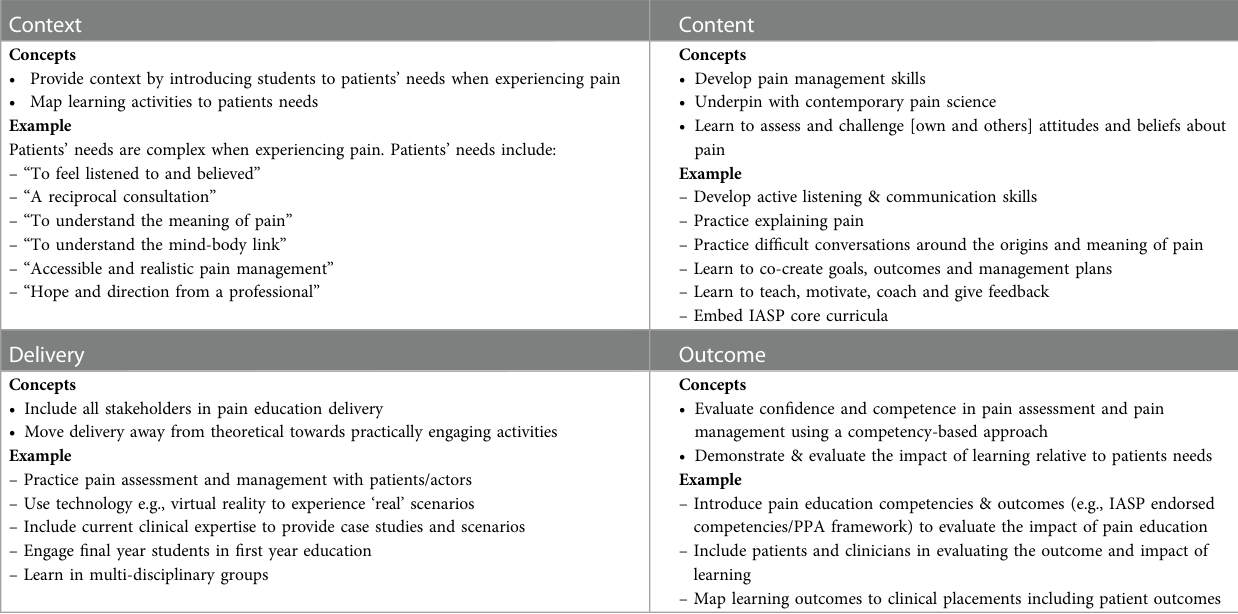
TABLE 1 Person-focused evidence-based pain education